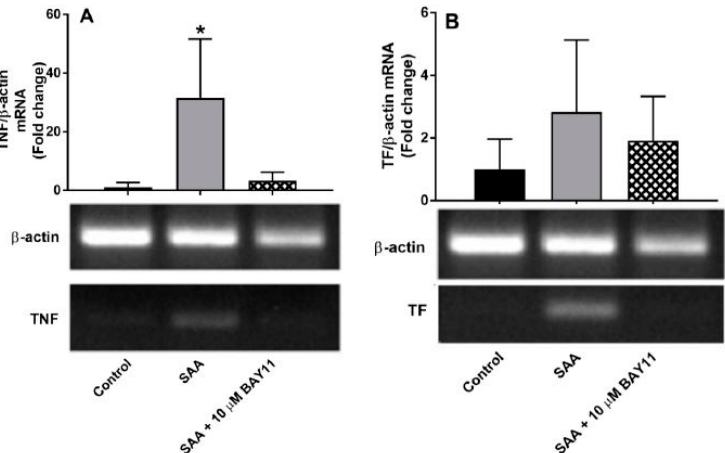
Figure 2. Relative gene expression in HCtAEC in response to SAA in the absence and presence BAY11-7082 under normoglycaemic conditions. HCtAEC were incubated with 10 µg/mL SAA or vehicle (control) with or without 10 µM BAY11-7082 pre-treatment under normoglycaemic conditions (5mM glucose). Total RNA was isolated after 4.5 h and gene regulation was assessed. Representative gels and semi-quantitative analysis are shown for (A) TNF (B) TF. Gene expression was normalised against β -actin and results represent fold change compared to control cells. Data shows the mean ± SD (n = 3 individual experiments each completed in duplicate; therefore, data represent 3 technical replicates); * P < 0.05 compared to control, # Where possible, target gene products were confirmed by sequence analysis (refer to supplementary data Figure S1-S3).